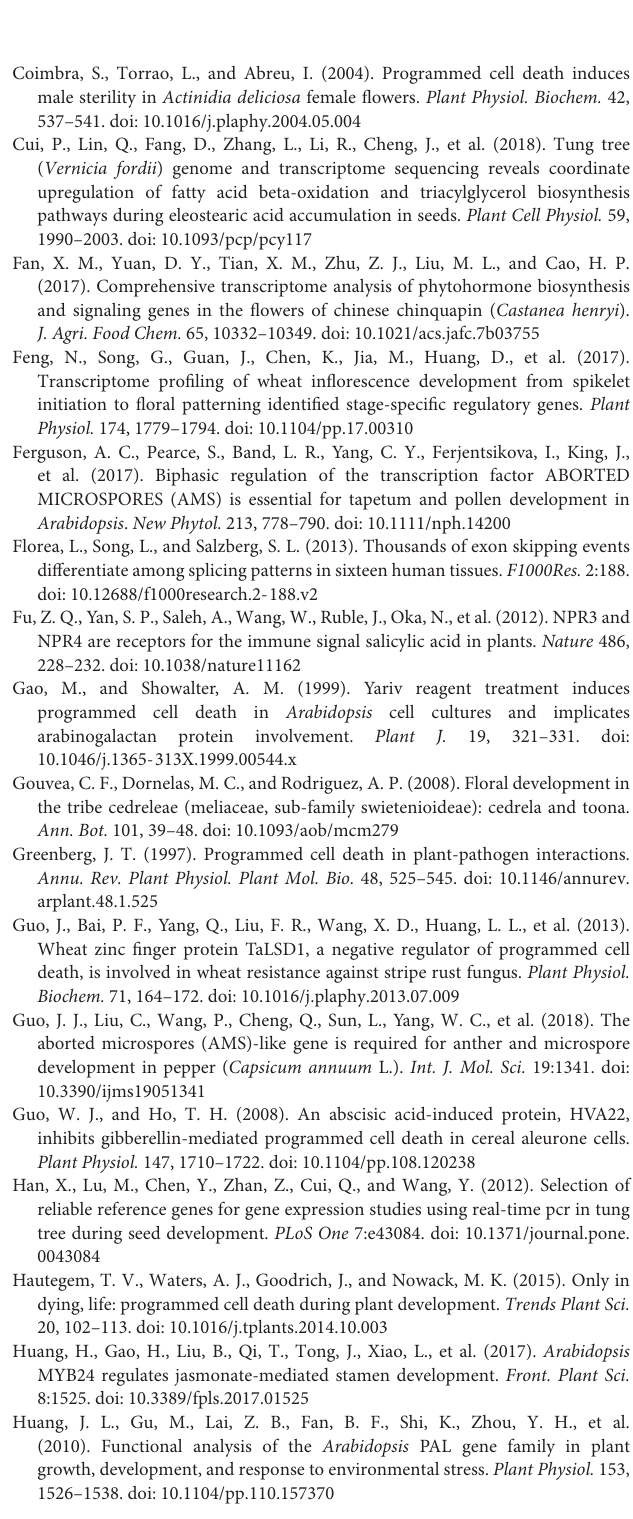
TABLE S5 | Expression patterns of PCD-related genes in male and female flowers. TABLE S6 | Salicylic acid pathway in male and female flowers. TABLE S7 | Co-expression networks analysis of genes in different module of female flowers in Tung